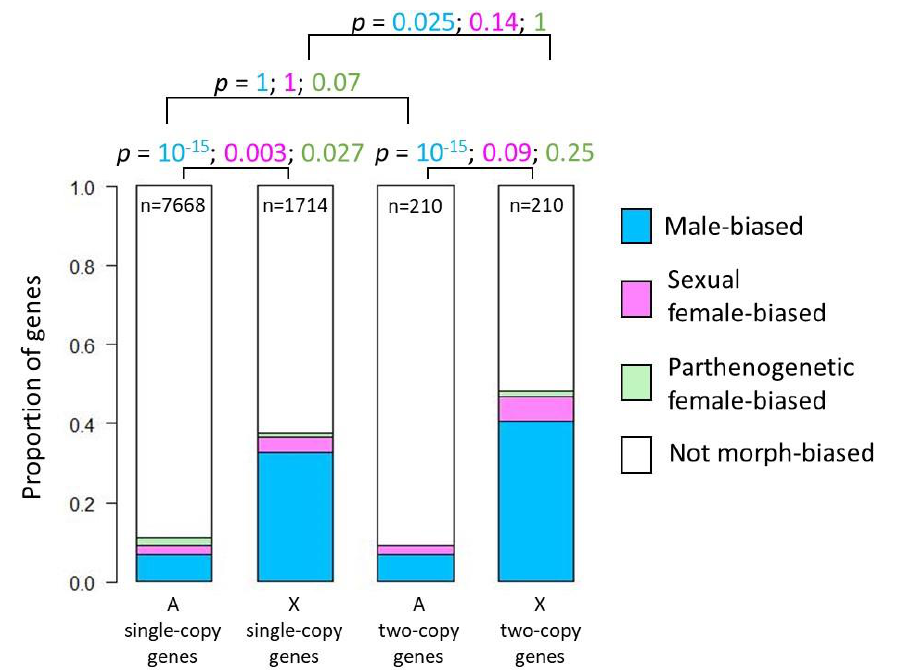
Figure 3: Proportion of genes showing preferential expression in different morphs, according to their number of copies (single or two copies) and chromosomal location (A: autosomes, X: X chromosome). Each two-copy gene has one copy on an autosome and the other on the X. P-values (Chi-squared tests) are shown, with font colors corresponding to the tested morph, according to the color of sectors. The number of genes composing each distribution is indicated on the